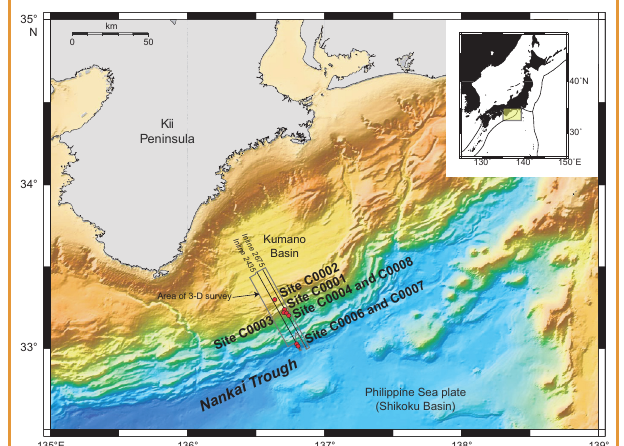
Figure 1. Location of drilled sites during NanTroSEIZE Project Stage 1 in the Nankai Trough off Kumano. Gray box = location of the 2006 three-dimensional seismic survey, black lines = 3-D inlines 2435 and 2675 (see Figure 2), red circles = location of drilling sites. Inset shows location of Nankai